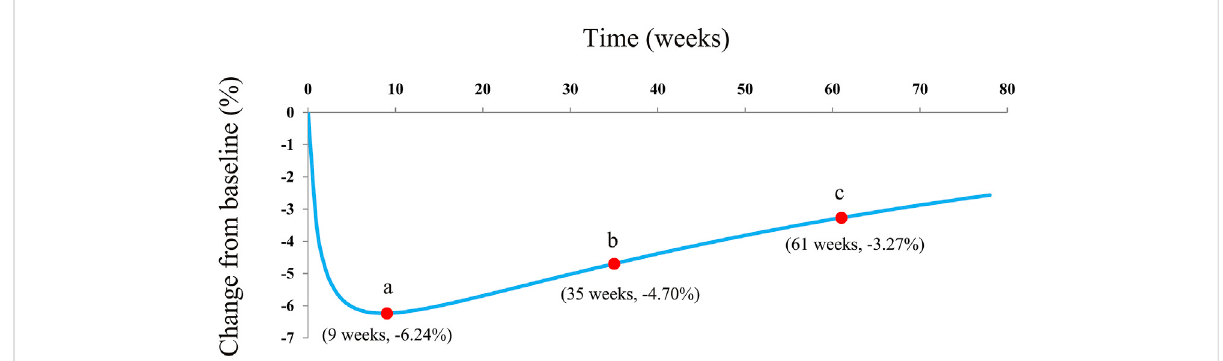
FIGURE 5 Model prediction. (A) Actual maximal ef fi cacy (AE max ) of dapagli fl ozin on HbA1c; (B) after it reached the AE max , the dapagli fl ozin therapeutic effectonHbA1c continuingthetreatmentfor0.5 years(26weeks),atweek35;and (C) after itreachedtheAE max ,thedapagli fl ozintherapeuticeffect on HbA1c continuing the treatment for 1 year (52 weeks) at week